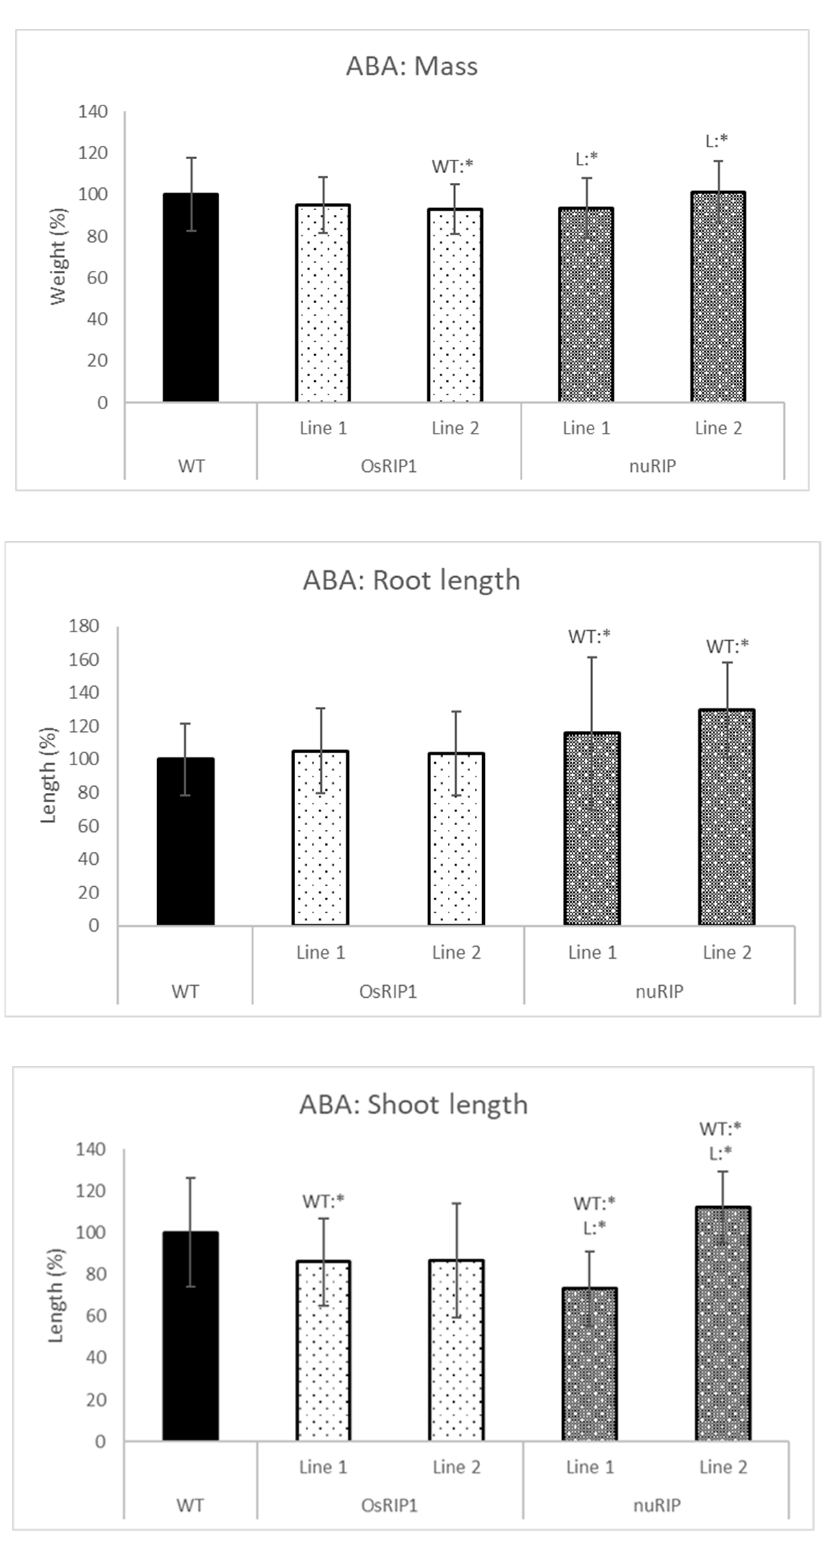
Figure 7. Total mass, shoot and root length of one-week-old plants from different transgenic lines subjected to 2 µM abscisic acid (ABA) compared to wild-type plants. WT:* refers to a significant difference to wild-type plants. L:* indicates a significant difference to the other transgenic line of the same construct. The histogram is based on averages; error bars represent the standard deviation. Each data point is gathered from 50 plants per line.